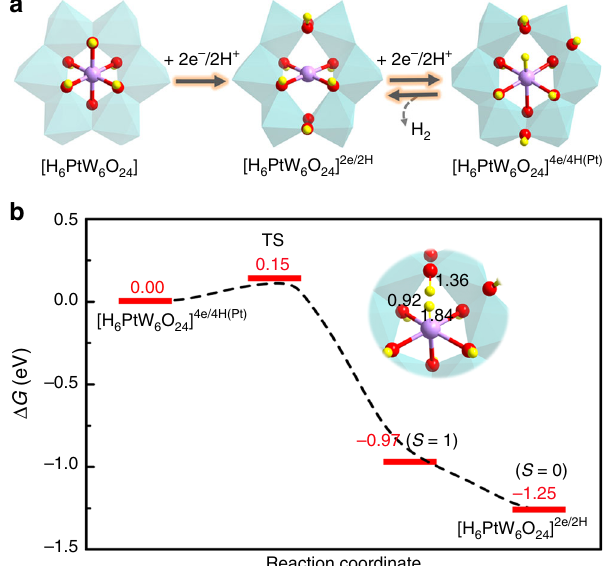
Fig. 3 H 2 evolution pathways over [PtW 6 O 24 ]. a Mechanistic scheme of the HER catalyzed by PtW 6 O 24 /C. [H 6 PtW 6 O 24 ] experiences a two- electron/proton-coupled reduction to form [H 6 PtW 6 O 24 ] 2e/2H (Pt II ), agreeing well with the intermediate detected by XAS. Two further